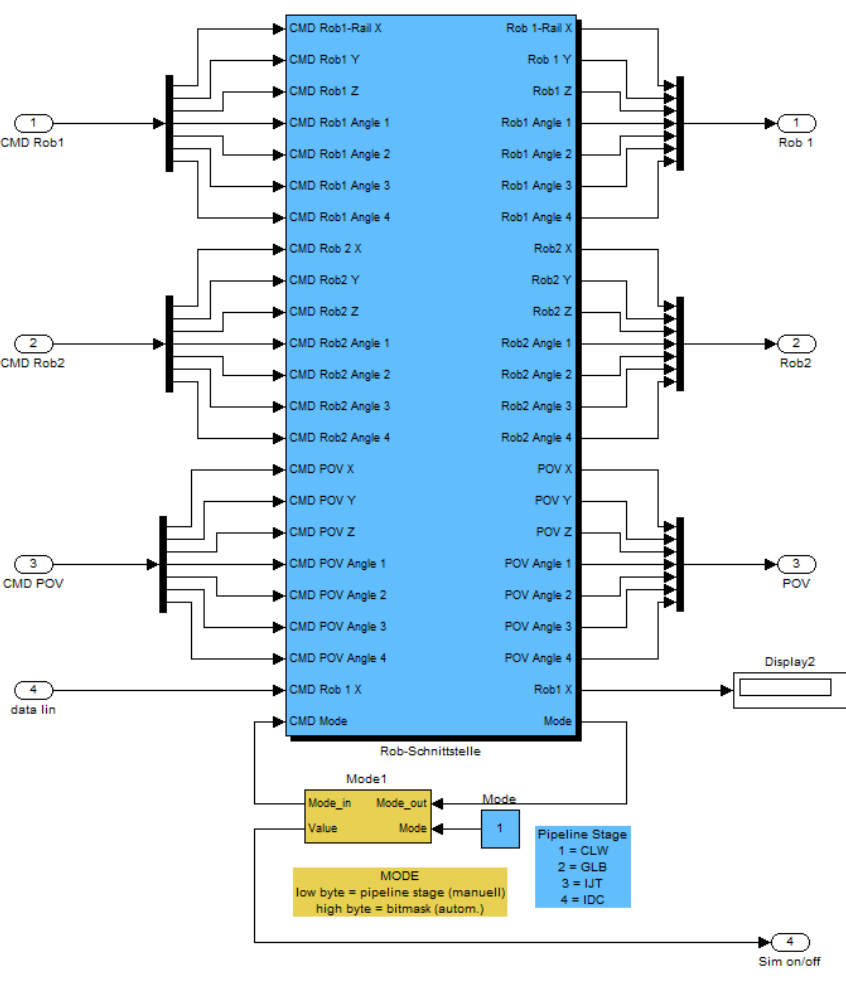
Figure 8: Synchronous Command Interface - Simulink Block